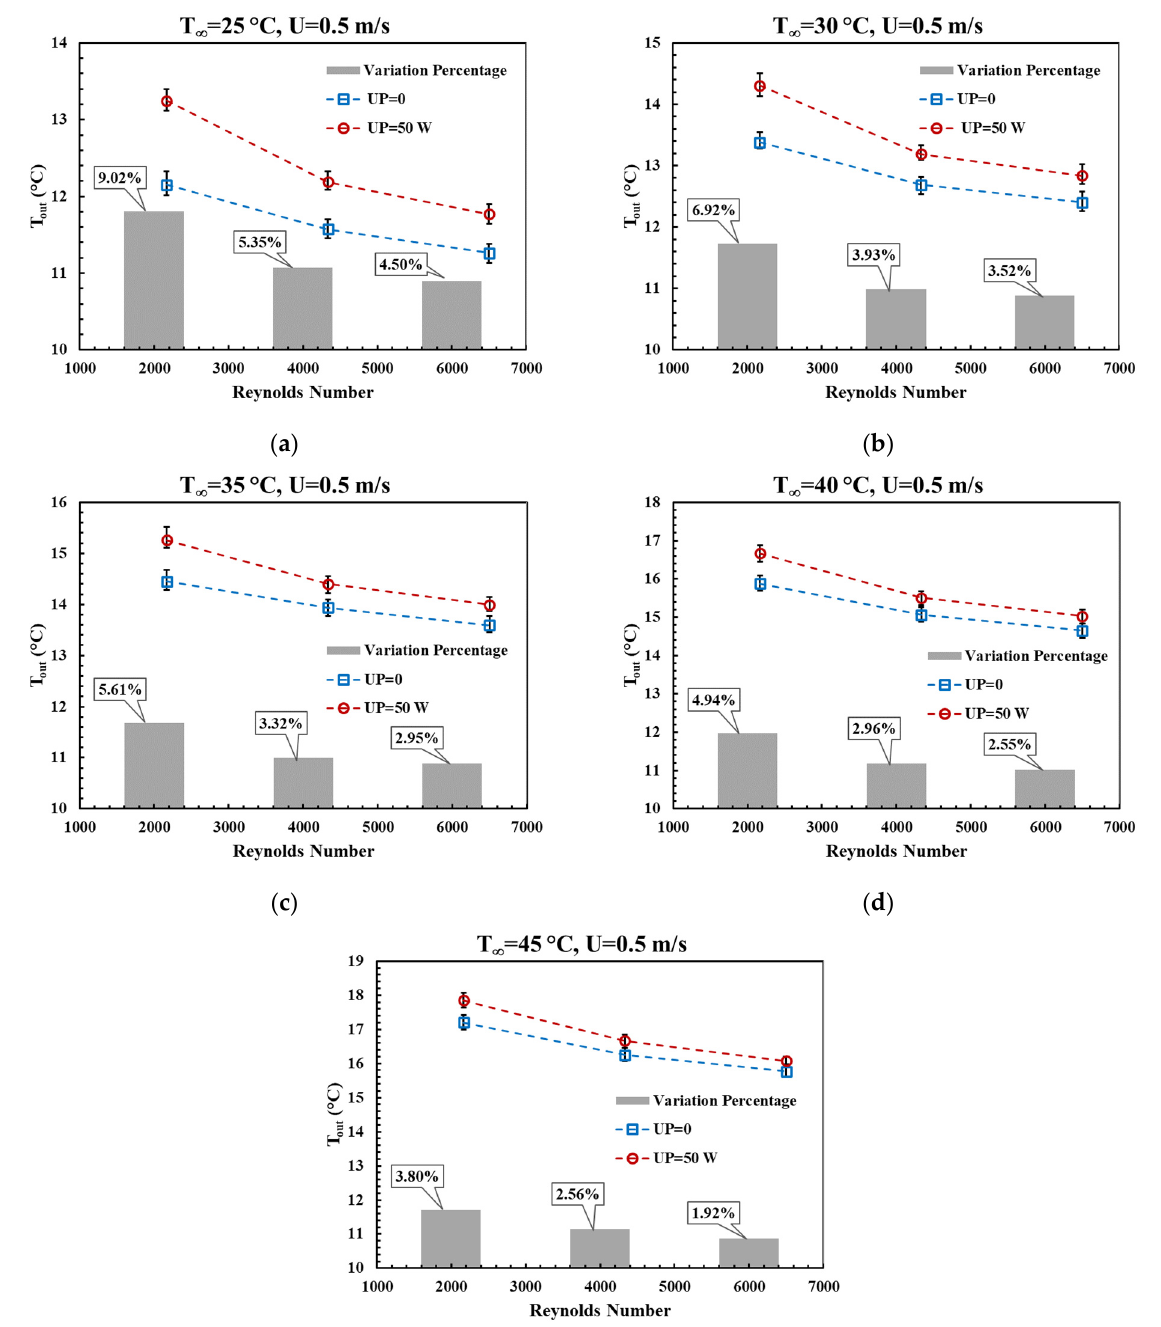
) and ( a ) 𝑻 (cid:2998) = 𝟐𝟓 (°𝐂), ( b ) ) and ( a ) T ∞ = 25 ( ◦ C), 𝒔 s